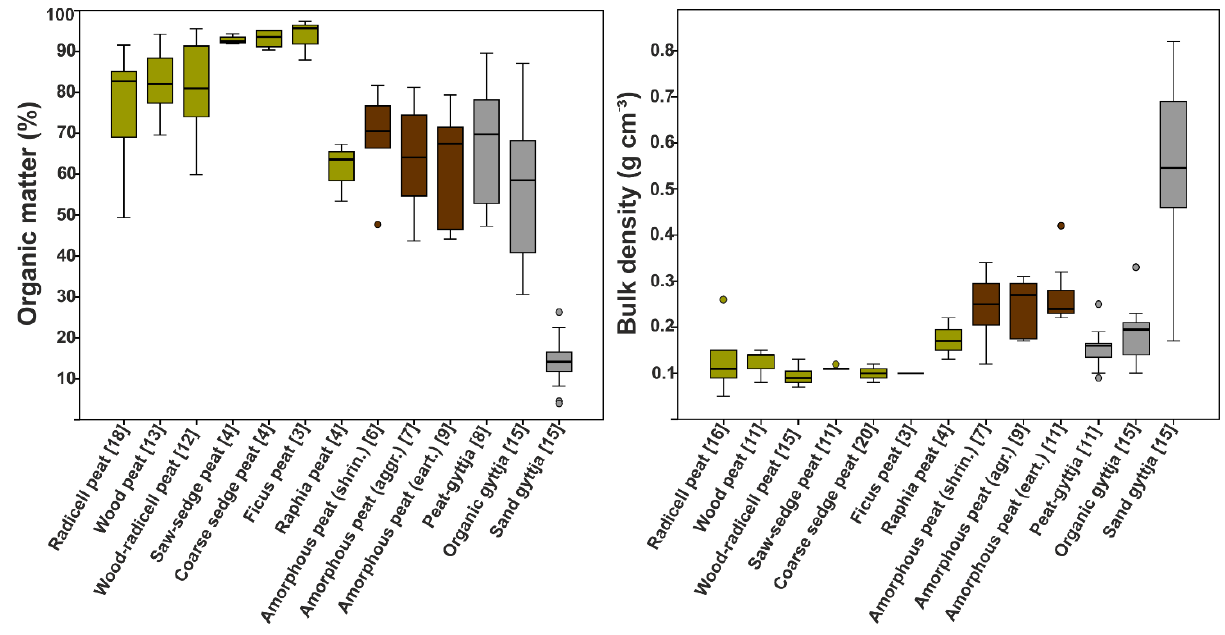
Figure 3. Boxplots of organic matter content and bulk density for each substrate. Boxes with greenish shading represent undegraded peat substrates, those shaded brown represent amorphous peat substrates, and grey shading indicates non-peat substrates.